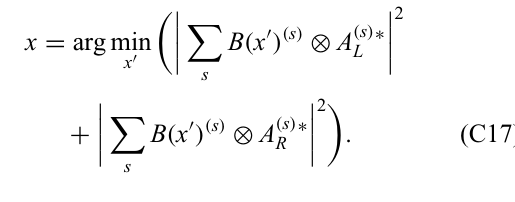
FIG. 16. Portion of a single-kink wavepacket state outside of the single-kink subspace κ ( 0 ) as a function of the wavepacket width σ for the Z 2 -broken Ising model g = 0.8, λ = 0, h = 0.007. We plot the error for two different ways of fixing the momentum-eigenstate freedom on the B tensors used to con- struct the wavepacket: the left orthogonal choice (cid:2) κ j | κ k (cid:3) = δ jk and the reflection-symmetrized choice (with B optimized using the left orthogonal conditions). In both cases the MPS tensors used to construct the state are tuned to the wavepacket momen- tum, which is p = 0. The projection into the κ ( 0 ) subspace uses B tensors optimized using the left orthogonal conditions and fully accounts for momentum dependence via a Fourier